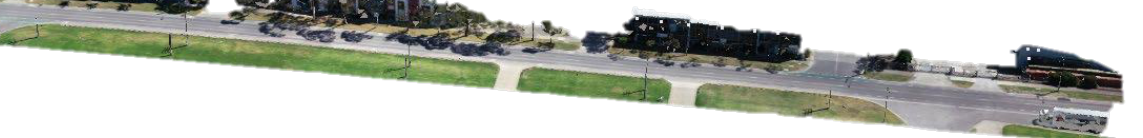
Figure 4. Turner Street reality model developed through photogrammetry.